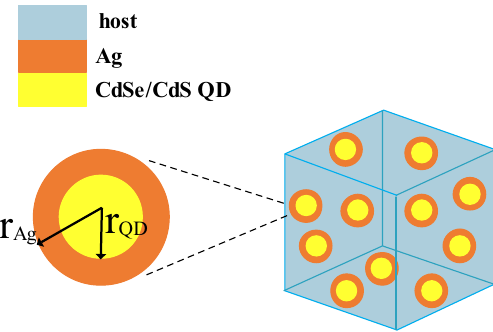
Figure 3. A sketch of the proposed low index layer obtained by dispersing silver-coated CdSe/CdS quantum dots within a polymer host. Here r Ag and r QD are the outer and inner radii of the nanoparticles